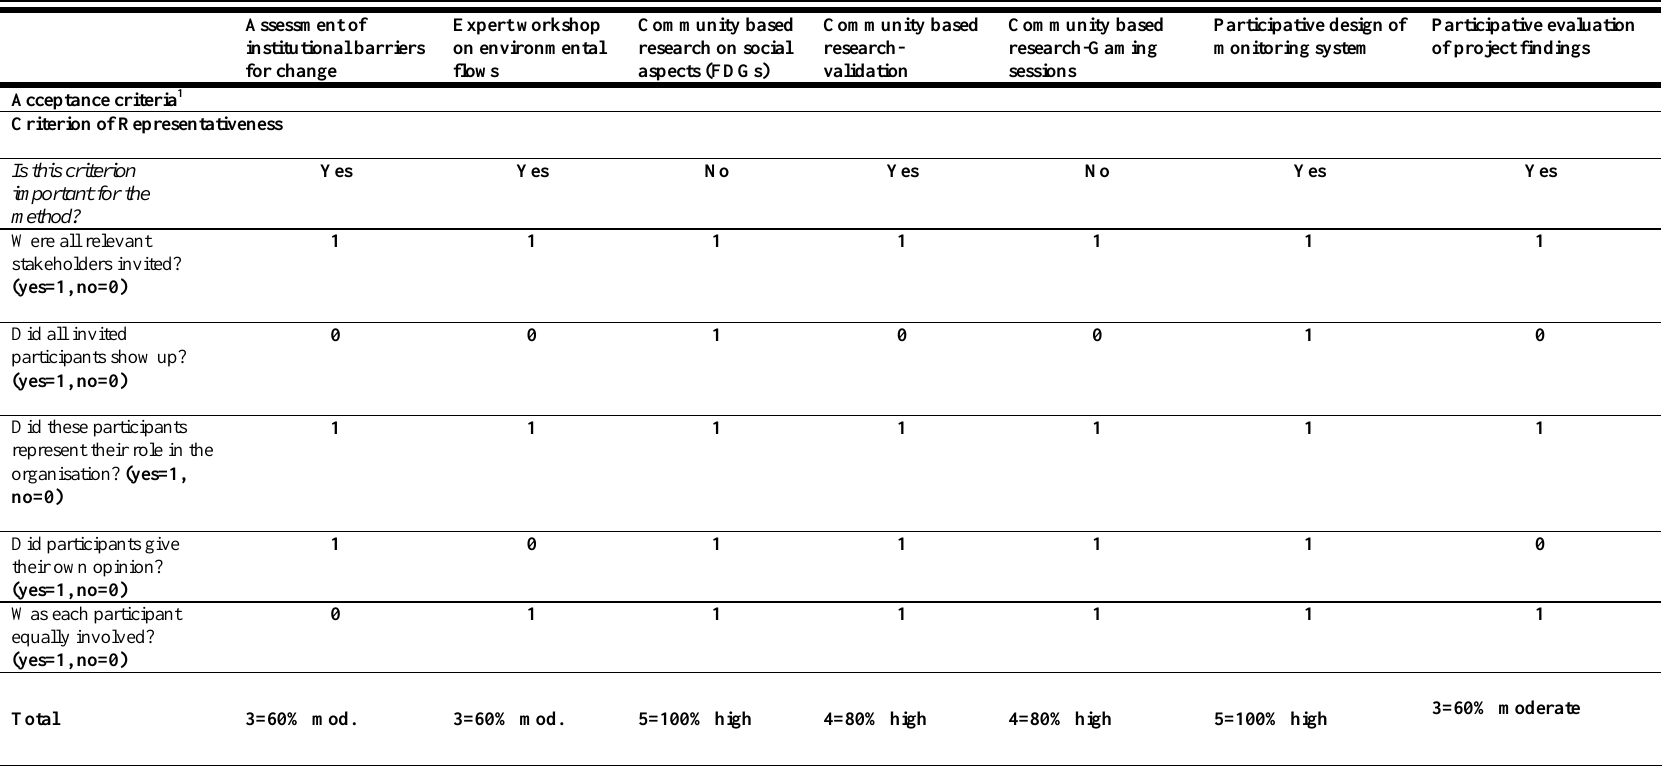
Table A.3 Evaluation framework (with questions) adapted from Rowe and